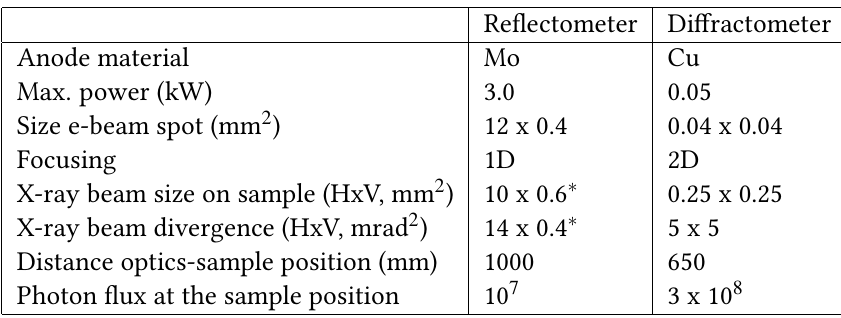
Table 1: Characteristics of the two X-ray